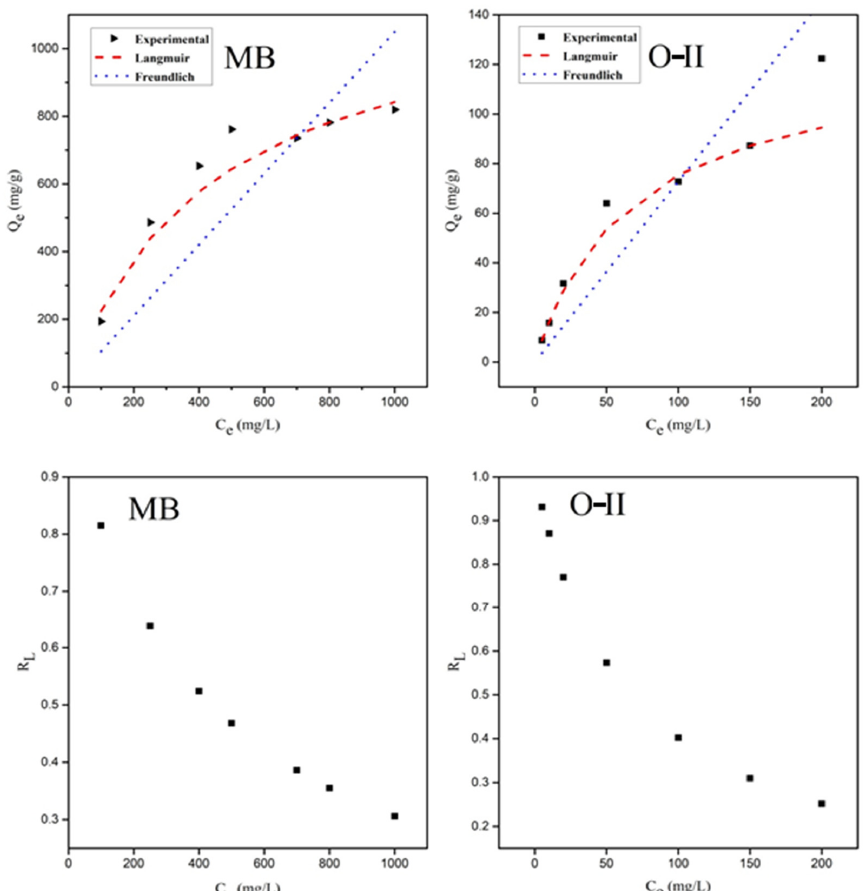
Figure 8. Langmuir isotherm model fitting and separation factor plots for MB and O-II.